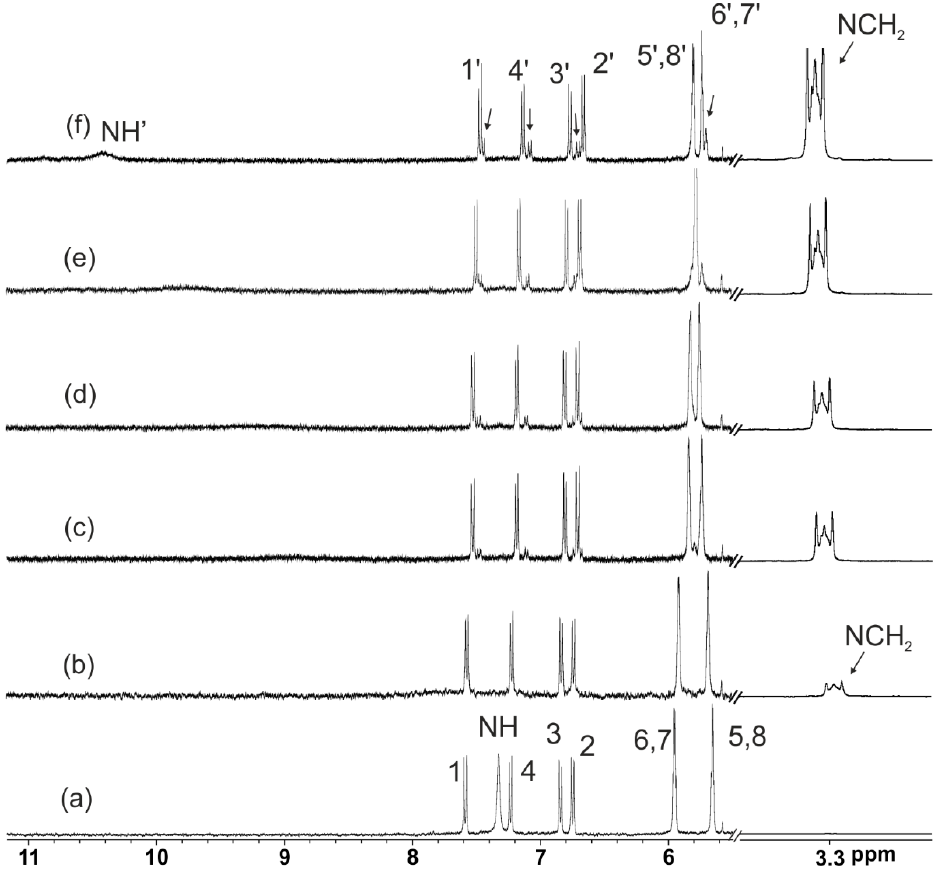
Figure 2. Selected downfield and upfield regions (aromatic and TBA regions, respectively) of the 1 H NMR spectra (400 MHz, CD 2 Cl 2 , 298 K) acquired during the titration of the mono-nuclear 2Au calix[4]pyrrole receptor ([ 2Au ] = 1.9 mM) with TBACl: ( a ) 0 ( b ) 1 ( c ) 4.5 ( d ) 10.5 ( e ) 21 and ( f ) 27 equiv. added. See Scheme 1a for proton assignment. The scale of the aromatic region is increased 16 times with respect to the upfield TBA region in order to show the presence of the second set of aromatic proton signals.